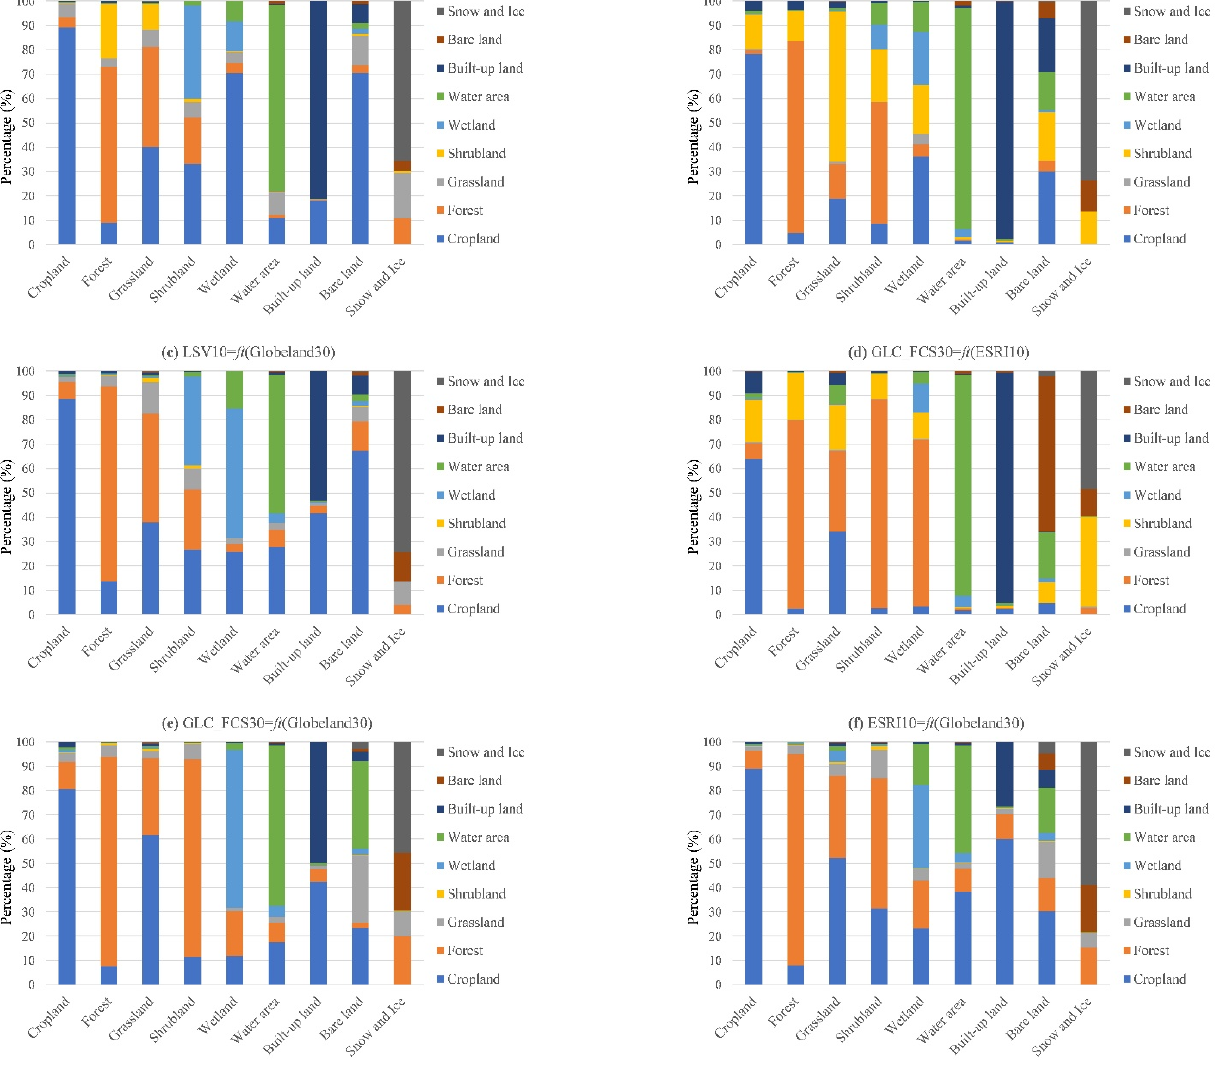
Figure 4. Degree of land type category confusion of different LULC datasets.